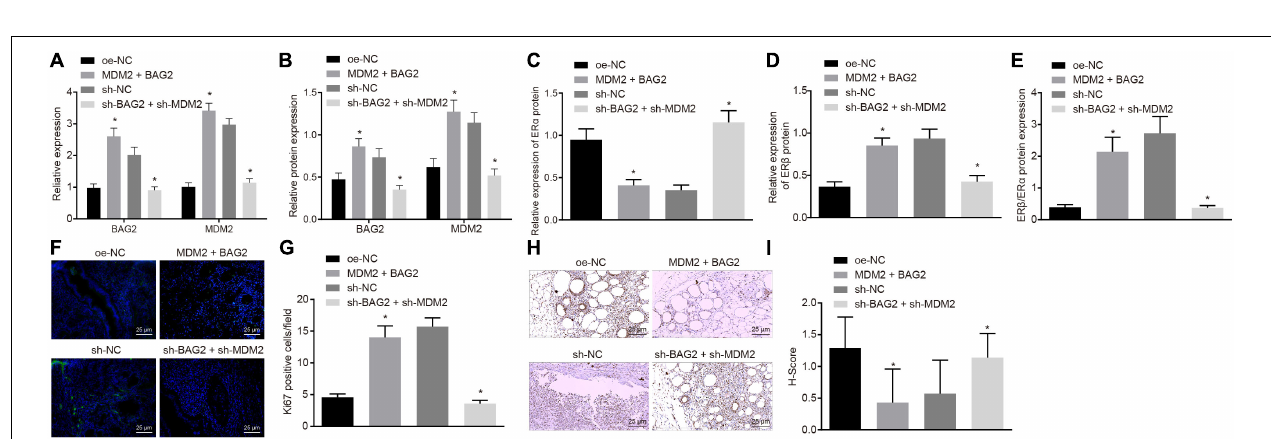
FIGURE 6 | BAG2-mediated inhibition of ER α and MDM2-mediated elevation of ER β contributes to the development of endometriosis. HESCs-NC cells were treated with overexpressed MDM2 and BAG2 with oe-NC as control, while HESCs-En cells were treated with sh-BAG2 and sh-MDM2 with sh-NC as control. (A) The mRNA expression of BAG2 and MDM2 determined by RT-qPCR. (B) The protein expression of BAG2 and MDM2 determined by western blot analysis. (C) The protein expression of ER α and ER β determined by western blot analysis. (D) The protein expression of ER β /ER α determined by western blot analysis. Comparisons between two groups were analyzed using independent sample t -test; * p < 0.05 vs. oe-NC treatment; # p < 0.05 vs. sh-NC treatment. Cell experiments were conducted in triplicate.